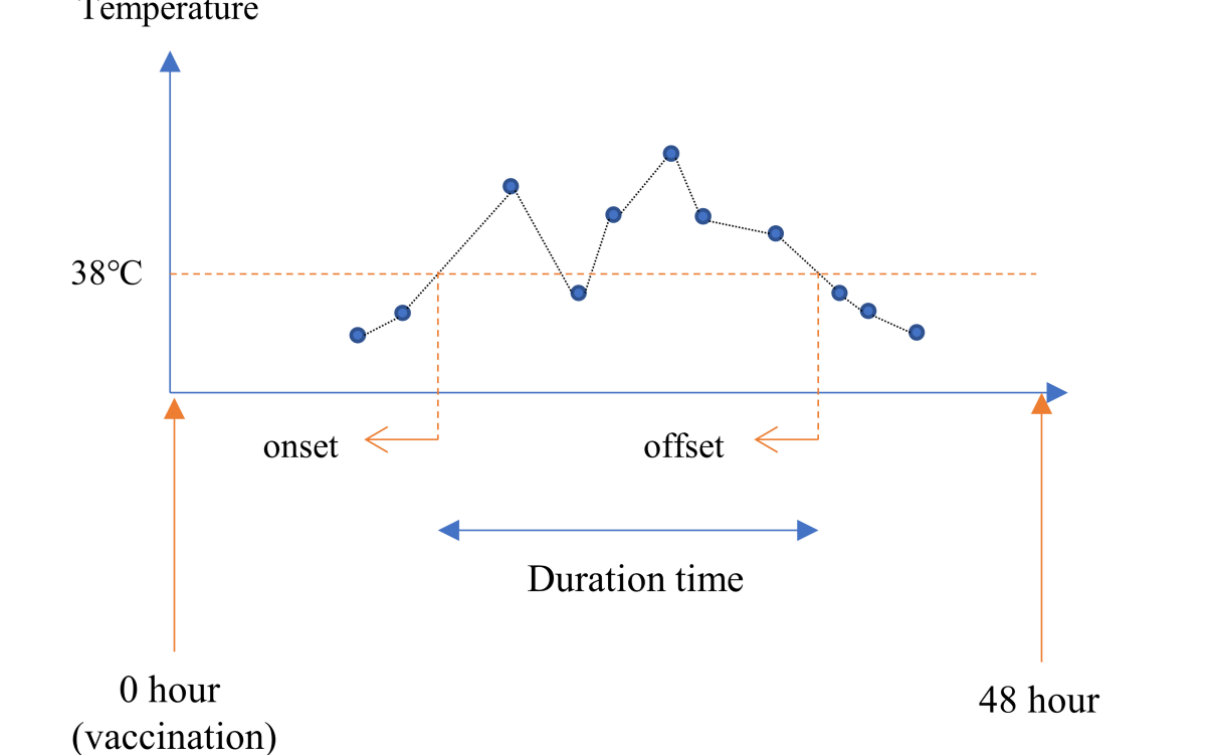
Figure 2. Onset, offset, and duration time definitions. The x-axis represents the time since vaccination and the y-axis represents the body temperature. The blue dot represents the actual body temperature. The black line between the blue dots is the imputated body